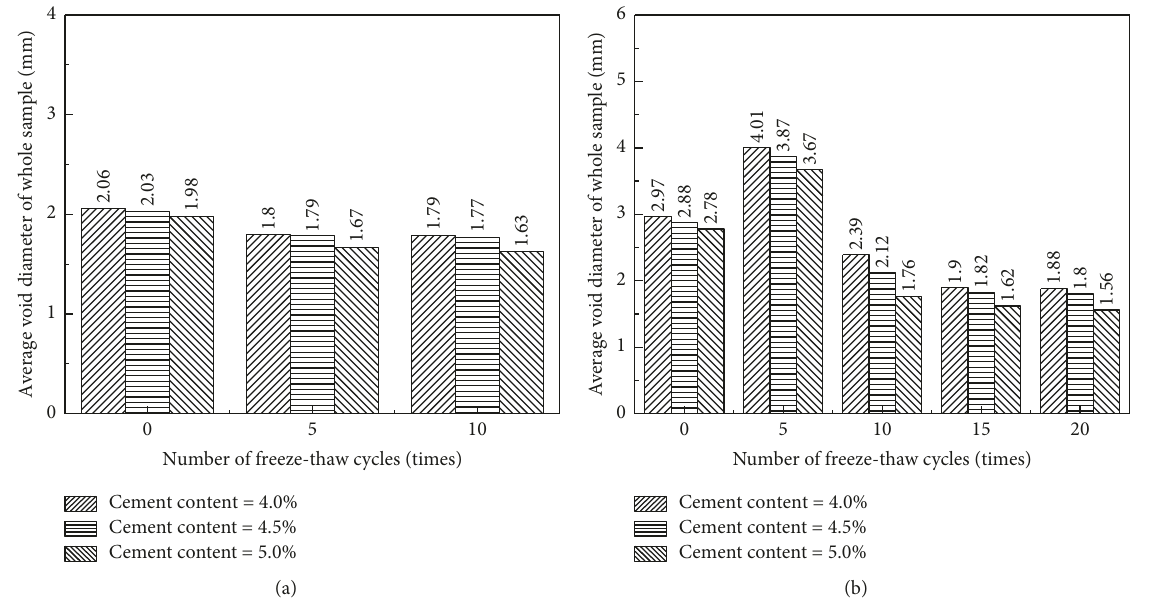
Figure 14: Effect of the number of freeze-thaw cycles, cement content, and curing time on the average void diameter of the sample: (a) curing time = 28 d; (b) curing time = 90